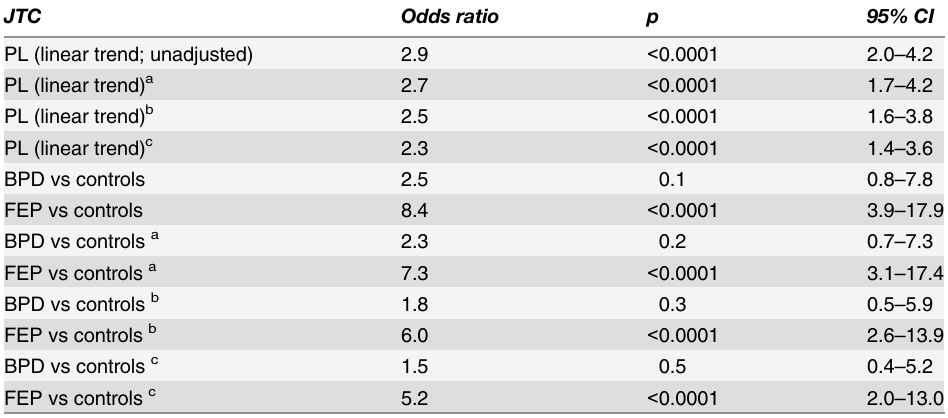
Table 3. Association between jumping to conclusions (beads < 1) and the group variable reflecting psychosis liability (linear trend and as 2 dummy variables compared with control group).